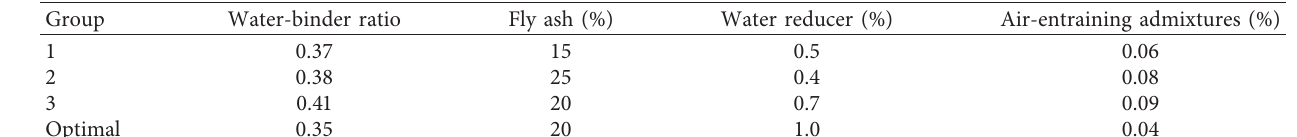
Table 11: The contrast mix proportion of C40 pavement concrete.